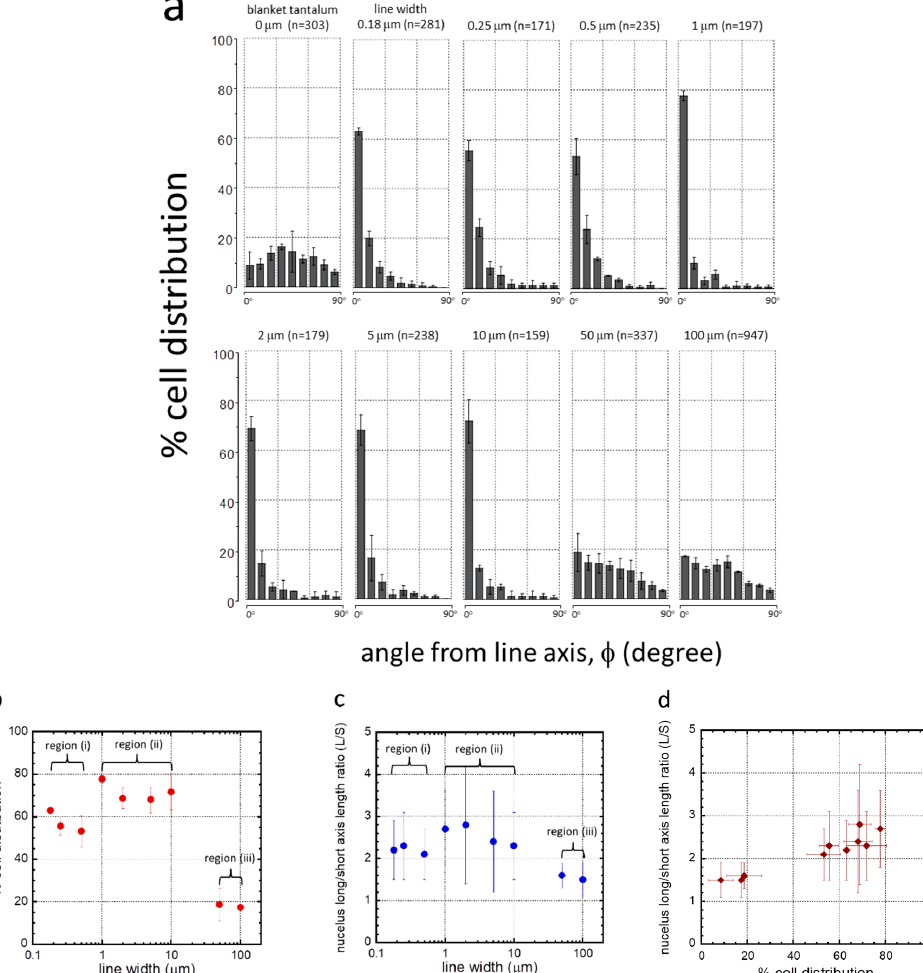
Figure 5. ( a ) Plots of cell orientation ( φ ) distribution in percentage on 0.18, 0.25, 0.5, 1, 2, 5, 10, 50, and 100 µ m-wide line comb structures. As a comparison, this figure includes measurements from blanket tantalum films. The number of cells inspected (n) on each pattern is displayed in an individual chart. Each bar represents a 10 ◦ bin of deviations from the line axis in either clockwise or anti-clockwise directions. For example, a cell nucleus deviated from line axis of –22 ◦ would fall into the third bin of each plot. These results show that most adherent cells are aligned to the line axes on comb structures in the range of 0.18 to 10 µ m. Adherent cells orientations are increasingly randomized on comb structures with line widths of 50 and 100 µ m. ( b ) Percent cell distributions that aligned within ± 10 ◦ of the comb structure line axes. ( c ) Plot of ratio of nucleus long and short axes as a function of comb structure line widths. ( d ) Plot of nucleus axis length ratio (L/S) as a function of percent cell distribution aligned within ± 10 ◦ of line axes.